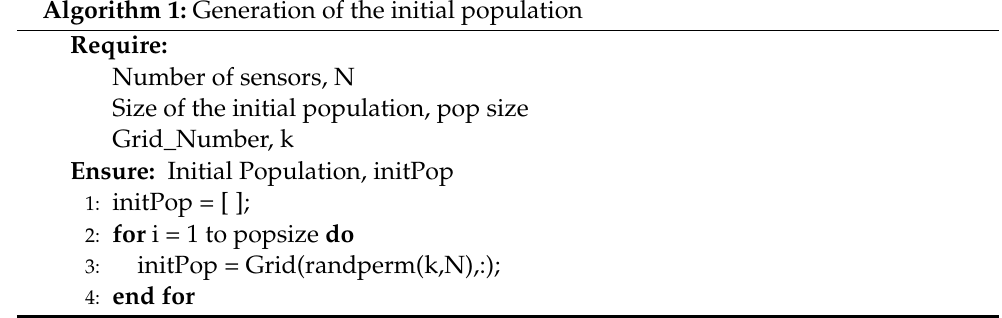
Algorithm 1: Generation of the initial population